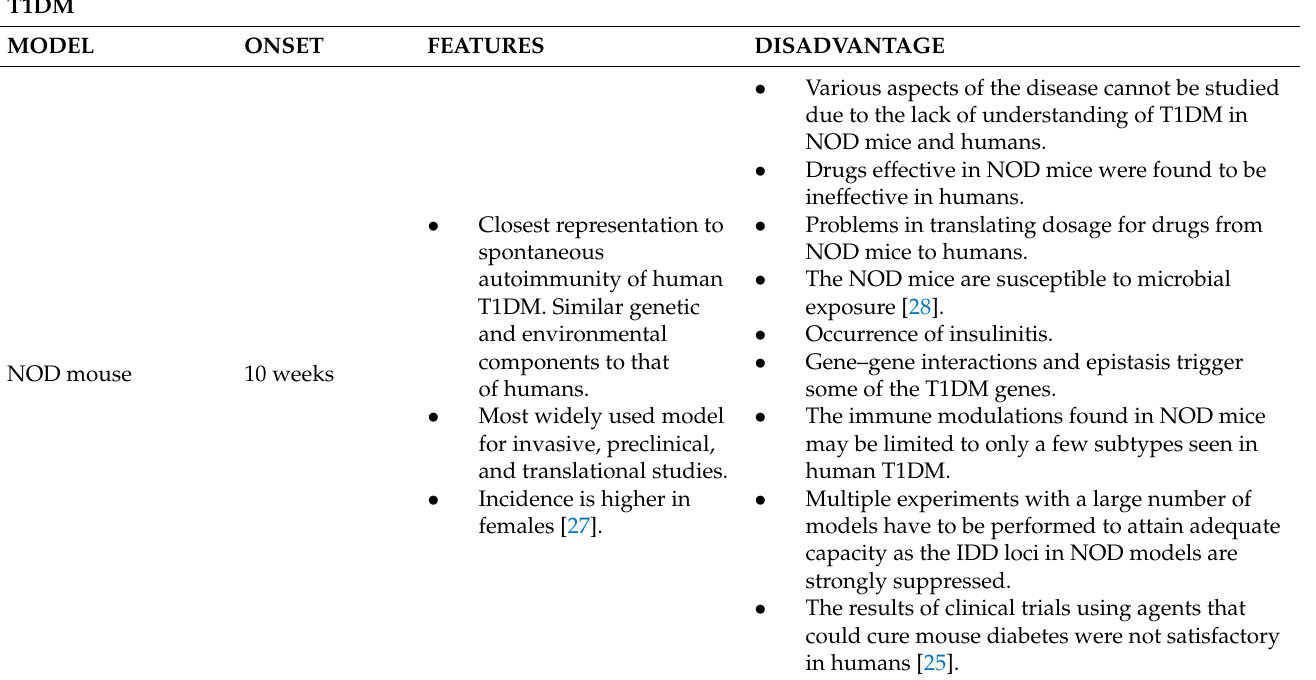
Table 1. Experimental animal models for diabetes and its related complications. T1DM